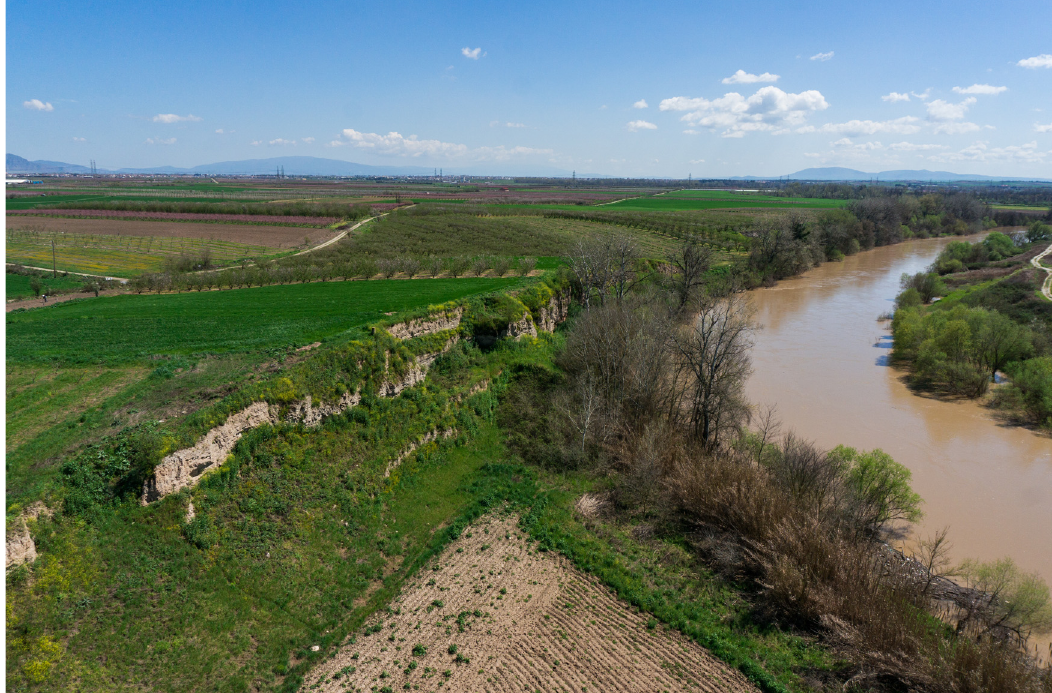
Figure 4: The tell of Argissa today ( left ) next to the Peneios River ( Copyright: Ephorate of Antiquities of Larissa )